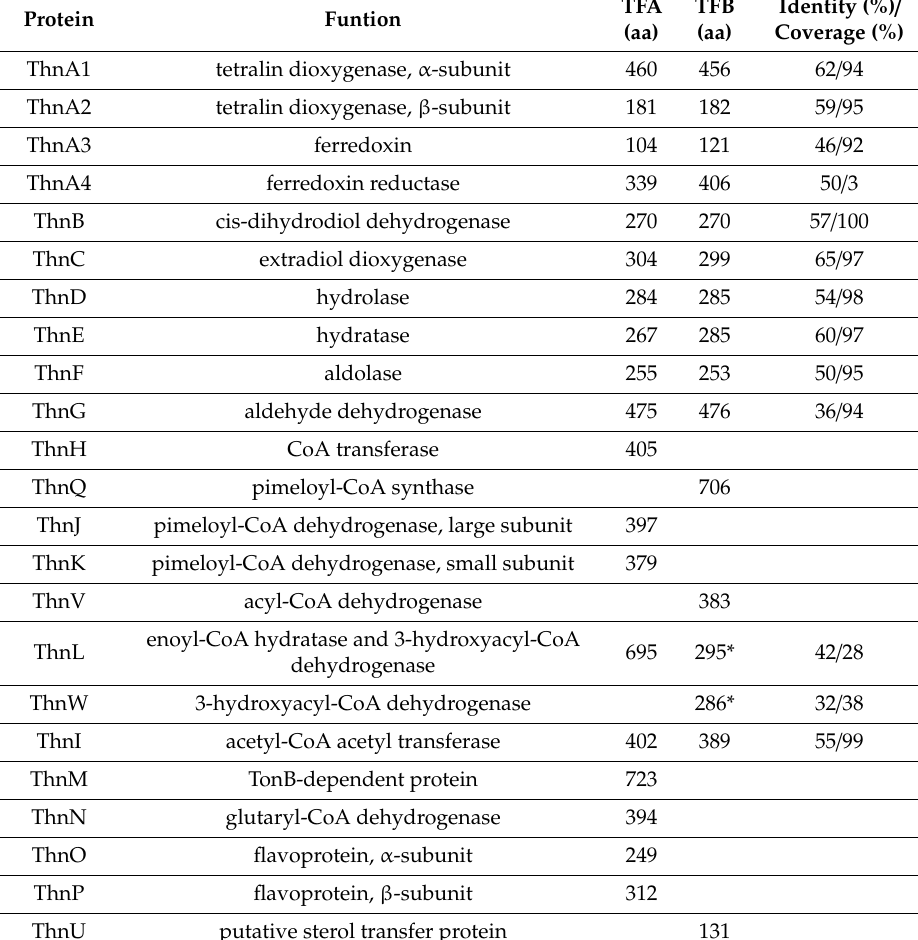
Table 1. Homology between TFA and TFB proteins.